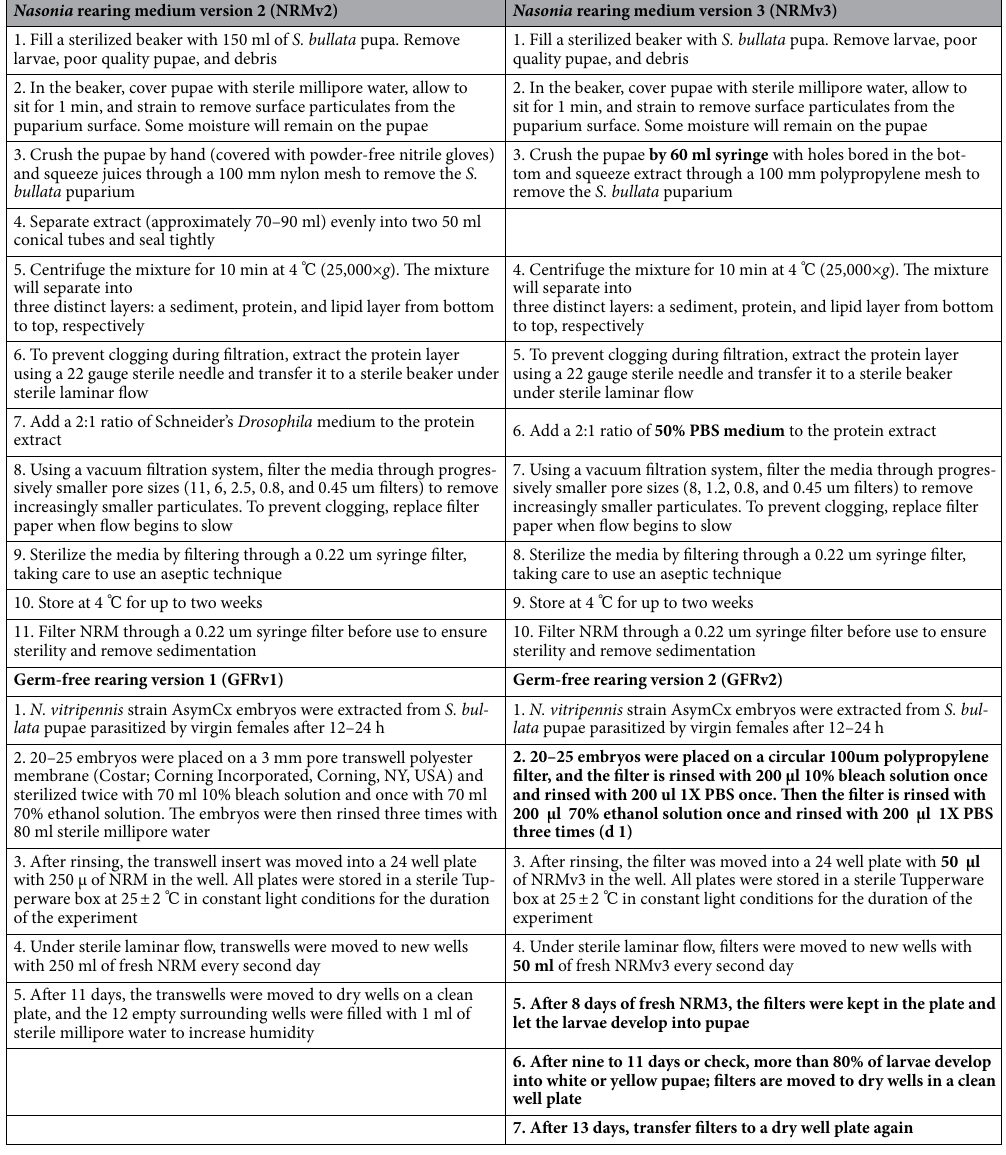
Table 1. Comparison between NRMv2 and NRMv3, GFRv1 and GFRv2. The words in bold are big distinctions between GFRv2 and GFRv1, NRMv3 and